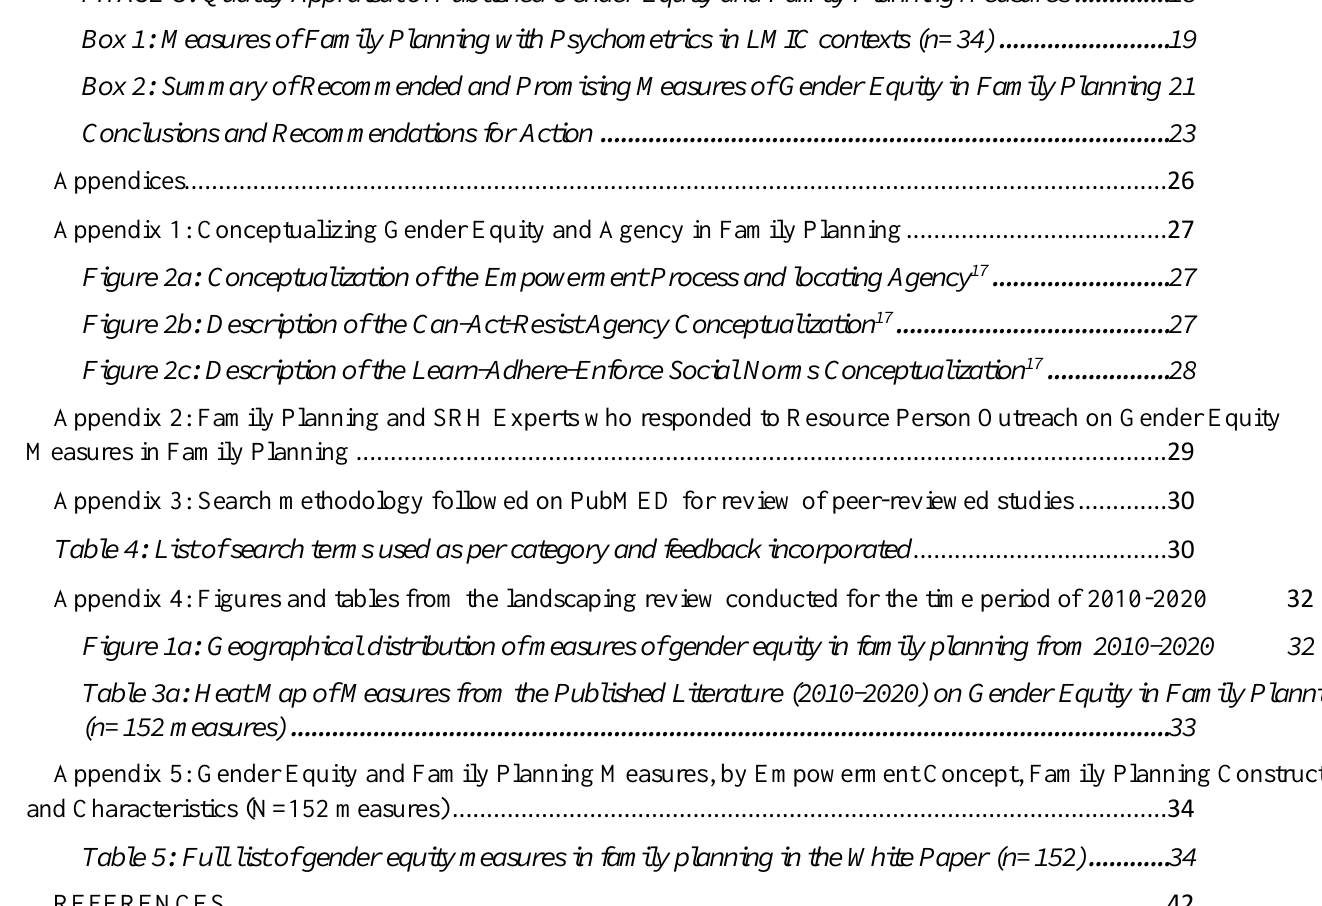
Table 2: Search terms used for conducting the review of literature ................................................... 12 Figure 1: Geographical distribution of measures of gender equity in family planning (2010-2021) . 14 Table 3: Heat Map of Measures from the Published Literature (2010-2021) on Gender Equity in Family Planning